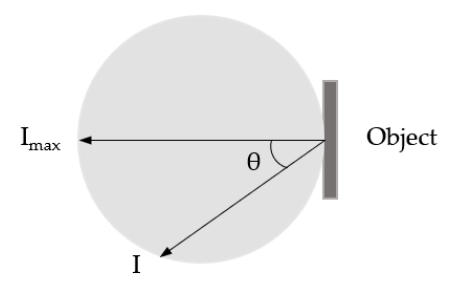
Figure A1. Lambertian backscatter. Accroding to the Lambert’s cosine law, the radiant intensity I (W · sr − 1 ) of a backscatter is the product of the peak intensity I max (W · sr − 1 ) in the normal direction and the consine of the angle θ between the direction of the reflection and the surface normal.